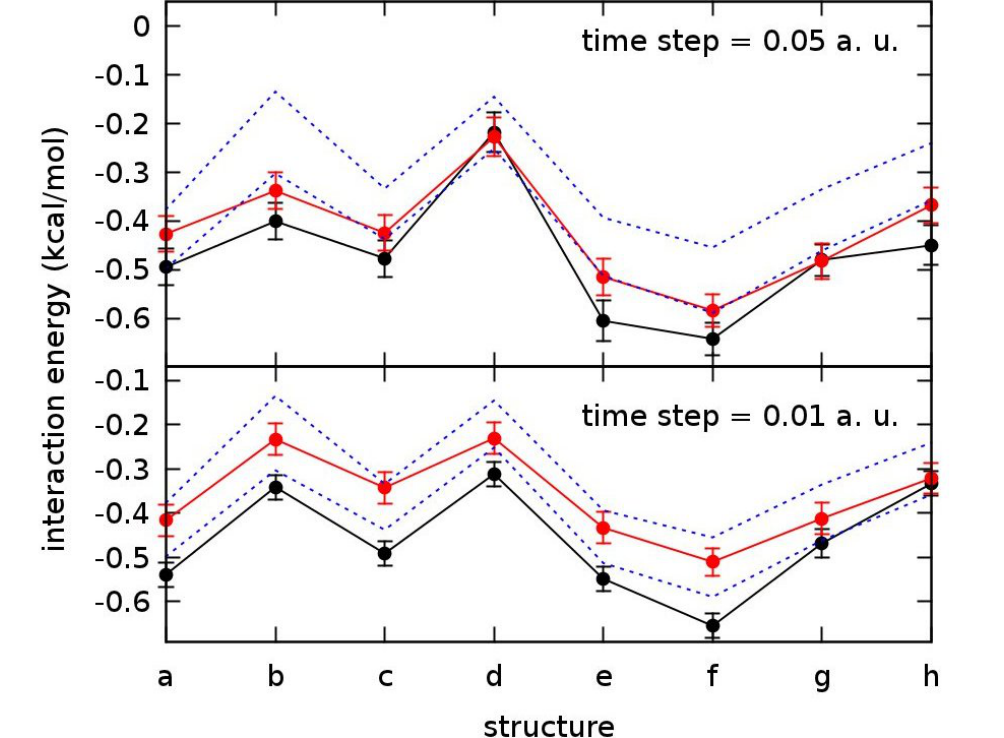
Figure 3. DMC interaction energies for the methane dimer structures considered in this work calculated at J-LGVB0 ( black ) and J-LGVB1 ( red ) levels of the theory. Dashed lines correspond to counterpoise corrected ( upper ) and uncorrected ( lower ) MP2/aug-cc-pvTZ data plotted for